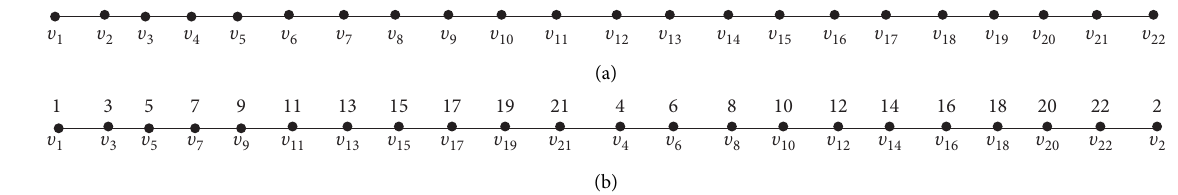
Figure 7: A path labeled by